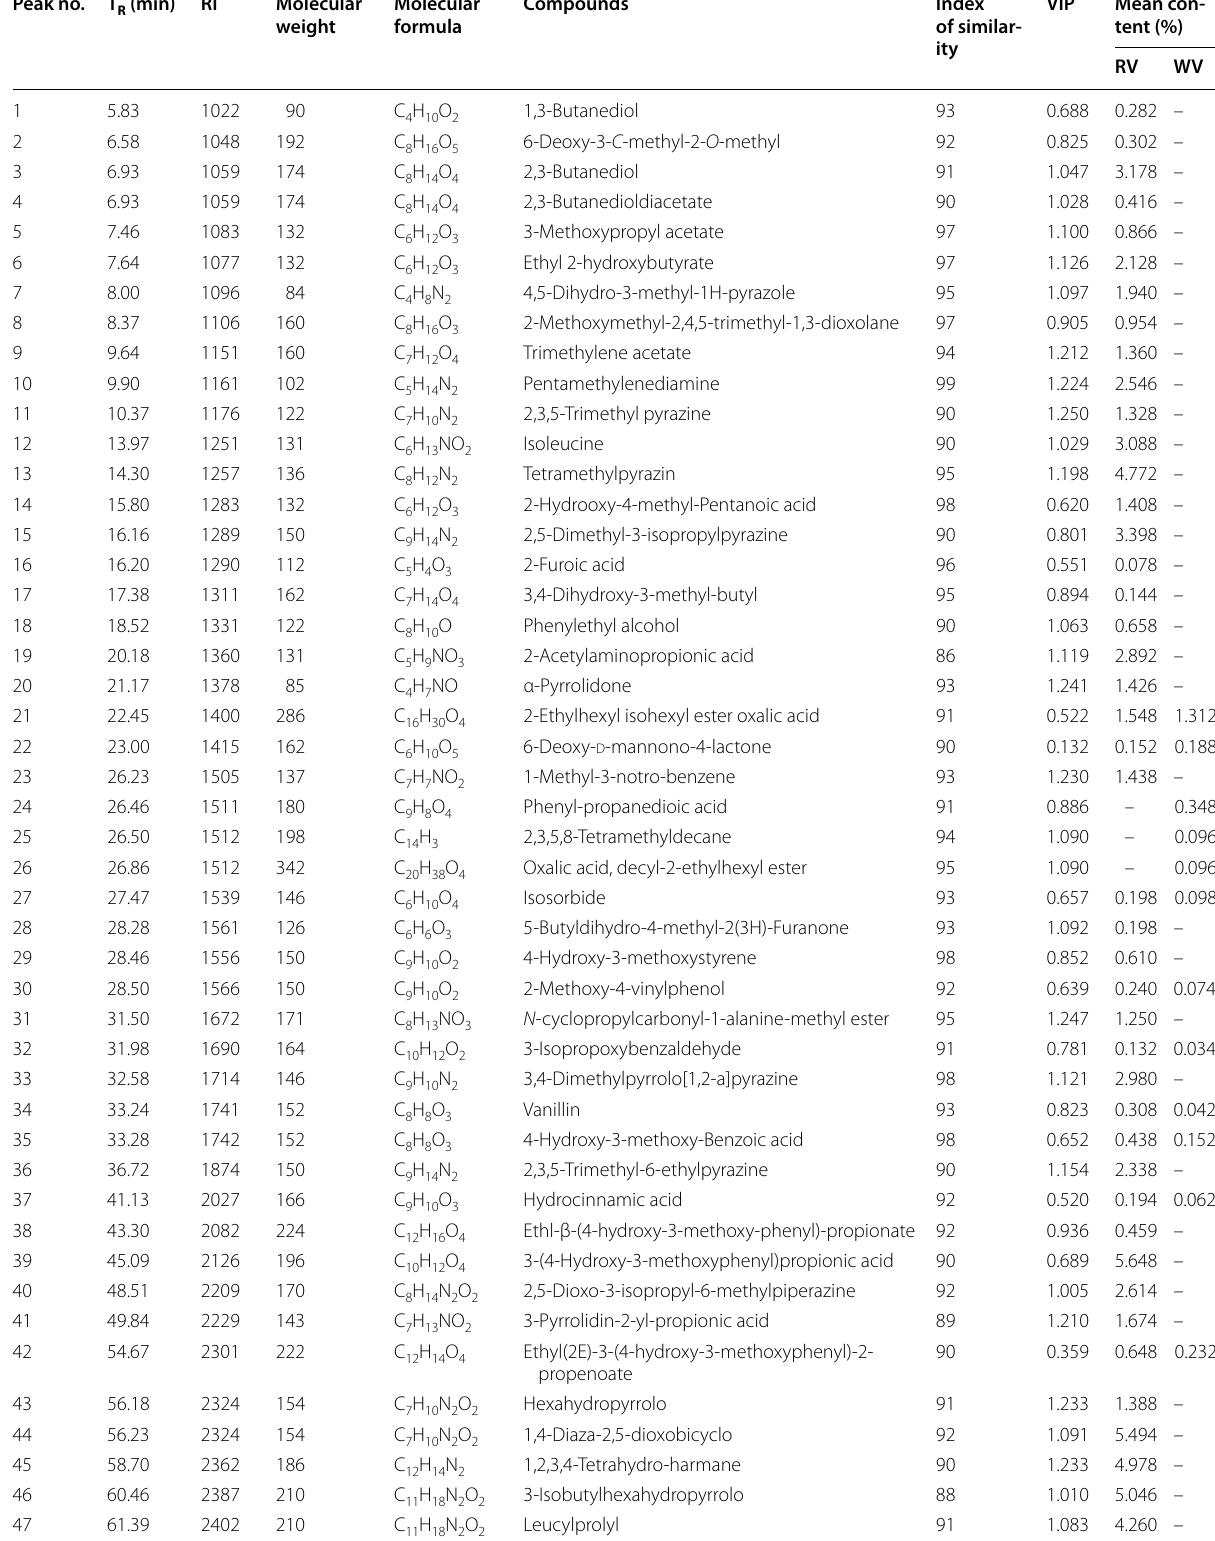
Table 1 Composition of two kinds of vinegar extract Peak no. T R